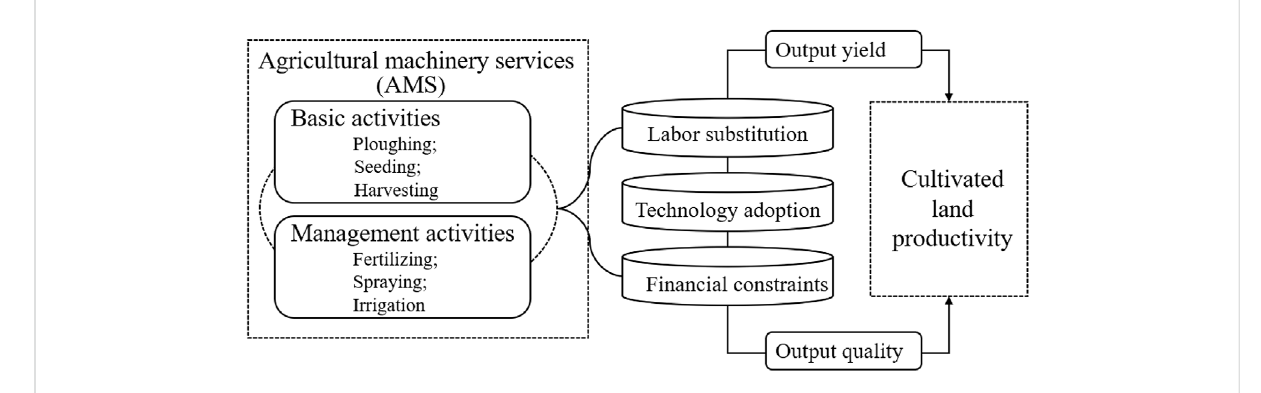
FIGURE 1 Conceptual framework of the impact of AMS on cultivated land